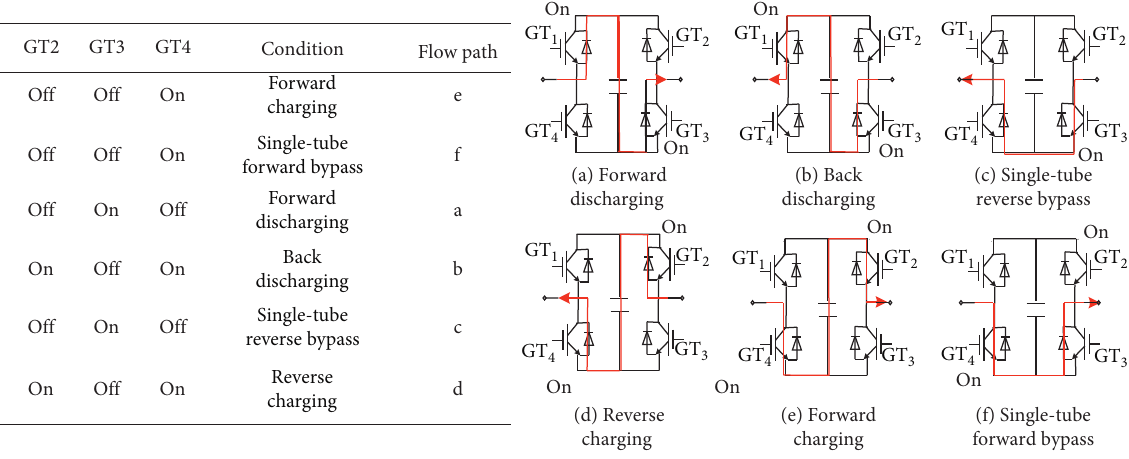
Figure 4: Full-bridge STATCOM working